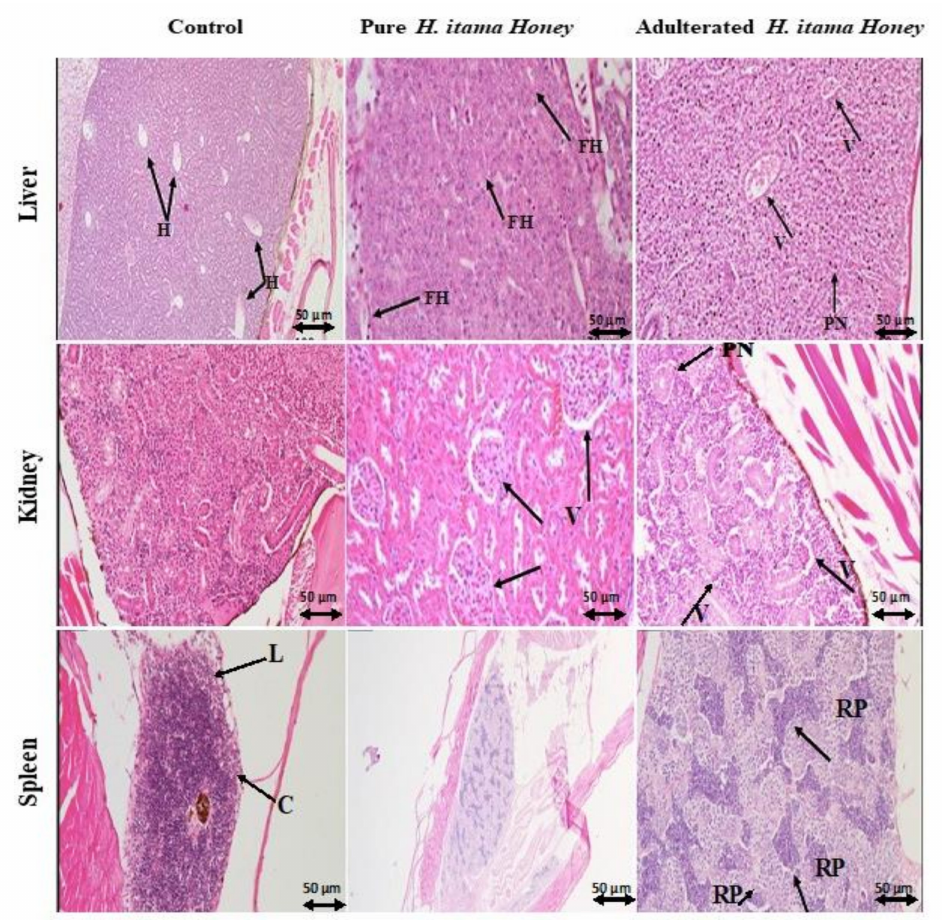
Figure 5. Histological alteration in the liver, kidney, and spleen of zebrafish treated with a different type of honey. Control groups with normal histological structure, the pure honey group with normal to the mild lesion, and the adulterated honey group with moderate to the severe lesion, H: hepatocyte, FH: foamy hepatocyte, V: vacuolation, PN: pyknotic nucleus, C: capsule, L: lymphoid tissue, RP: red pulp. H&E, bar = 50 µ